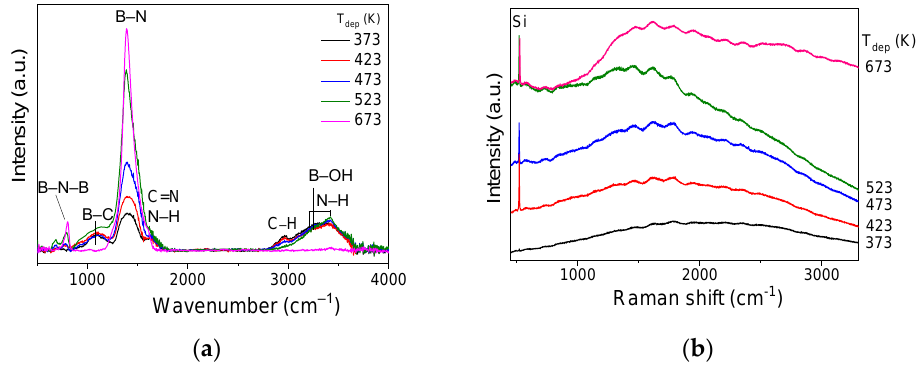
Figure 7. Evolution of ( a ) FTIR spectra and ( b ) Raman spectra of BC x N y O z :H films obtained by PECVD methods using TMAB + N 2 mixture.